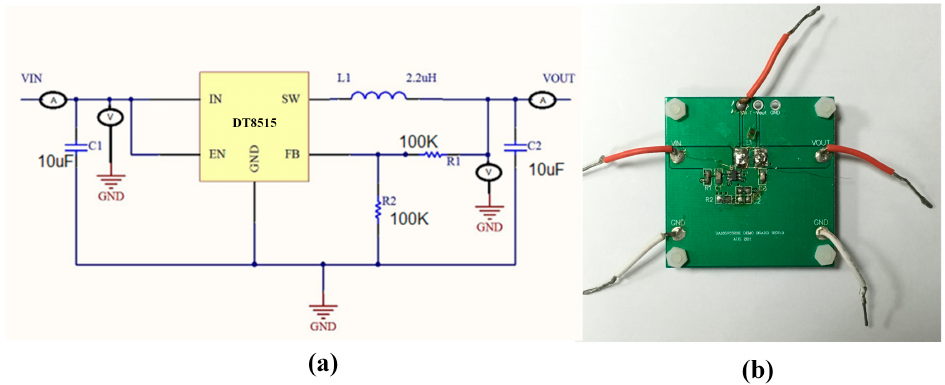
Figure 9. Application circuit of the DC/DC Buck Converter. ( a ) Schematic circuit diagram; ( b ) PCB (Printed Circuit Board) used for testing.